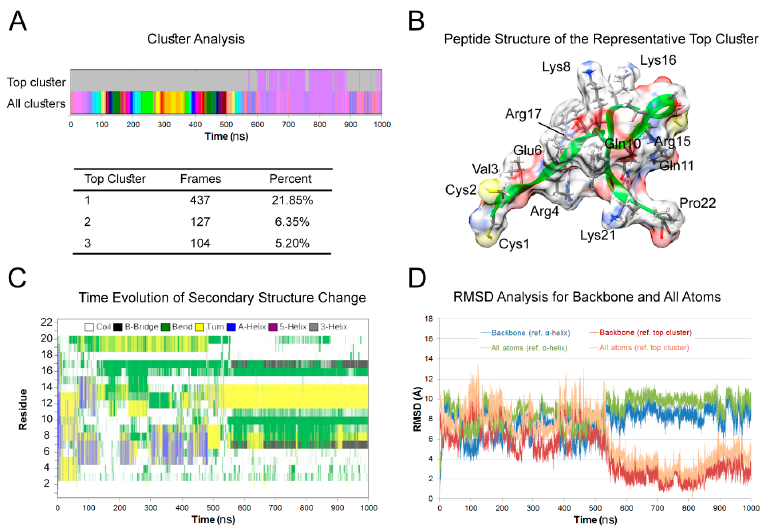
Figure 1. Molecular dynamics simulation of peptide. ( A ) Cluster analysis of Molecular dynamics( MD) trajectories. Snapshots were taken every 50 frames and the final number of frames was 2000. The top cluster was predominant in the second half of the simulation. ( B ) The peptide structure at frame #81,251 is representative of the top cluster. The backbone ribbon is shown in green while the molecular surface is shown in standard heteroatom color. There are 10 intra-model hydrogen bonds in this frame donated by the following atoms: Arg4 (HE, HH21), Gln10 (HE21, HE22), Gln11 (HE21), Arg15 (H, HH11), Arg17 (HE, HH21), and Asp18 (H). Only three of these involved the backbone. ( C ) Time evolution graph of secondary structure change. After the first 550 ns of the simulation, the peptide displayed a stable secondary structure as follows: 1–6 (coil), 7 ( β -bridge), 8–11 (bend), 12–14 (turn), 15 (coil), 16 (bend), 17 ( β -bridge), 18–22 (coil). ( D ) Root mean square deviations (RMSD) analysis for backbone and all atoms. The structure deviated from the original α -helix in the first frame by range of 5–11 Å. The RMSD for the backbone of the top cluster was below 4 Å, while for all atoms was below